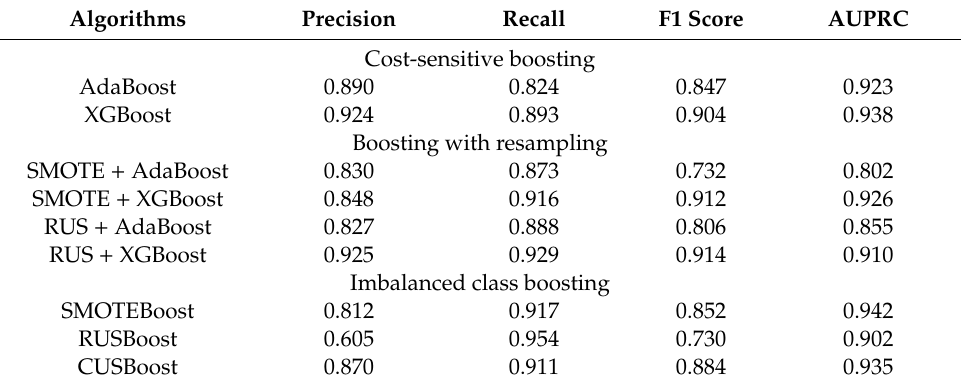
Table 5. The performance of boosting algorithms (Dataset